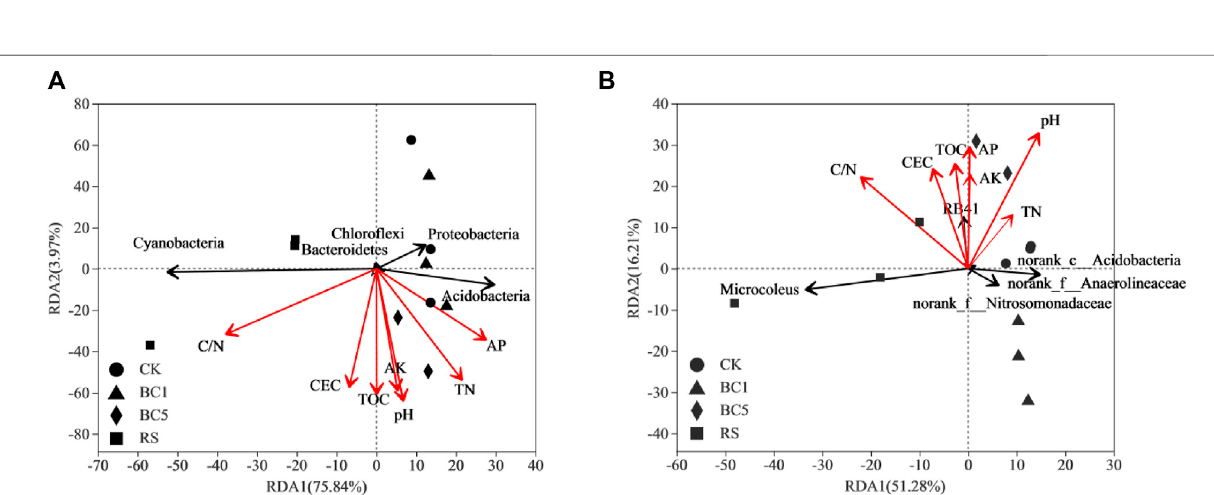
Frontiers in Environmental Science |